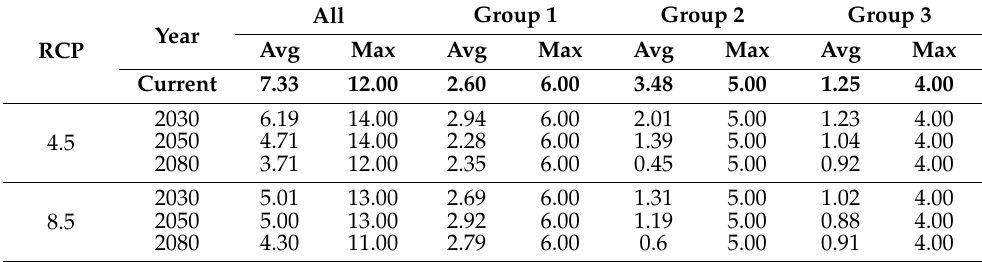
Figure 4. Potential species richness of amphibian species under the current climate. The figures ( a – d ) show the richness of amphibians for Group 1, Group 2, Group 3, and overall. Table 5. Basic statistics for the species richness of amphibians for different habitat characteristics in South